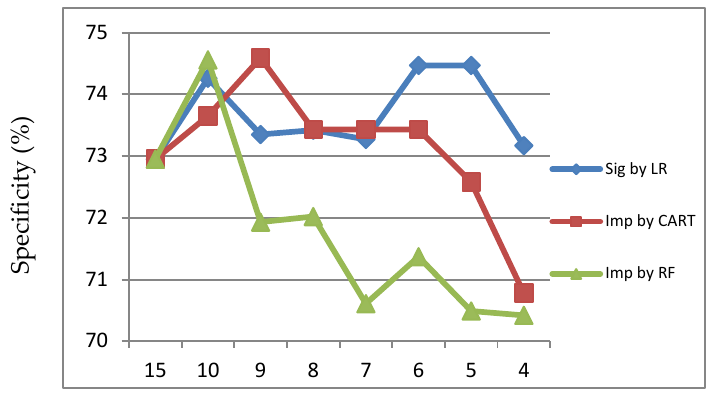
Figure 17. Specificity of CART with input of significant or important variables.